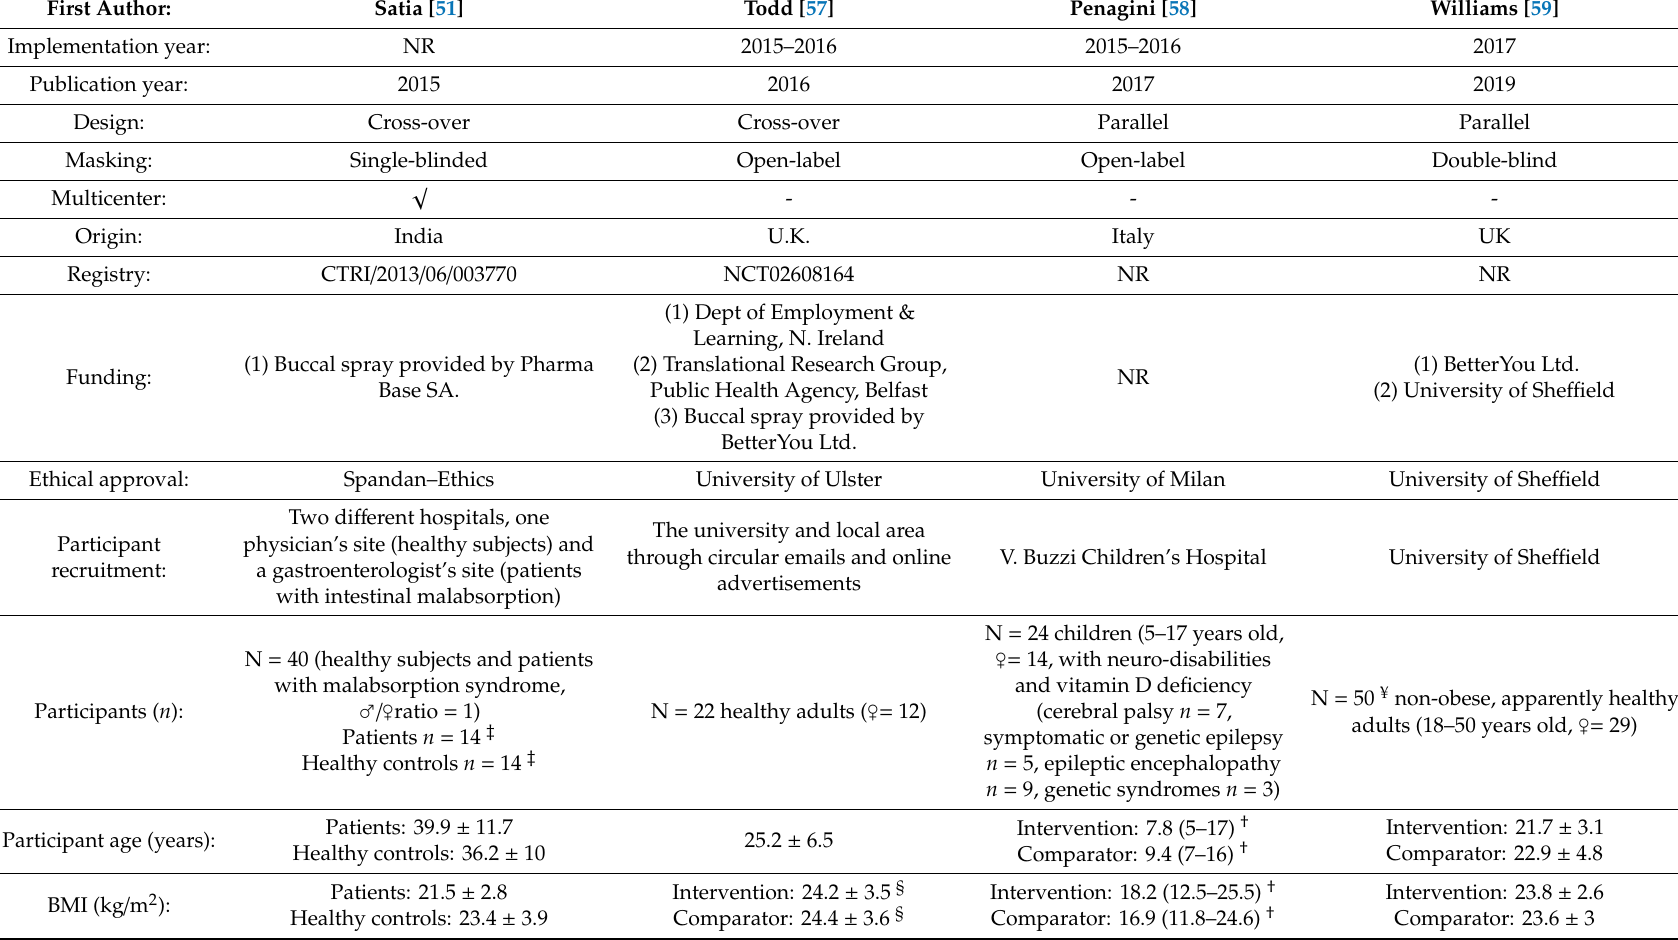
Table 2. Characteristics of the included randomized controlled